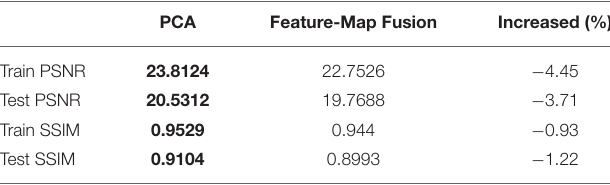
TABLE 3 | PSNR and SSIM scores of training and testing images from FrScatNets with fractional orders α 1 = α 2 = 1 on the CelebA